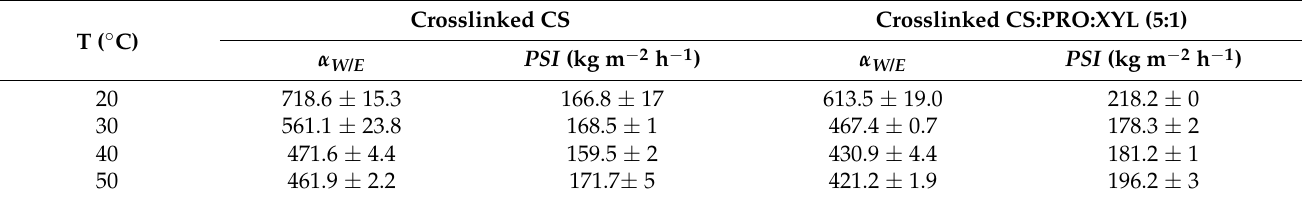
Figure 9. Comparison of ethanol and water mass-transfer resistance through membranes. Points connecting lines are to improve readability of the graph. Table 2. Water/ethanol separation factor for studied membranes and corresponding pervaporation separation index.